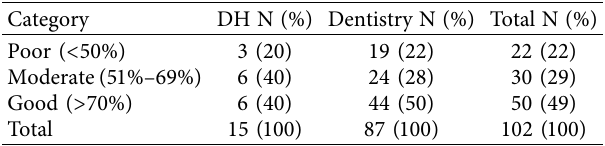
Table 2: The number of students to score between certain thresholds for the self-reported knowledge score ( n � 102).